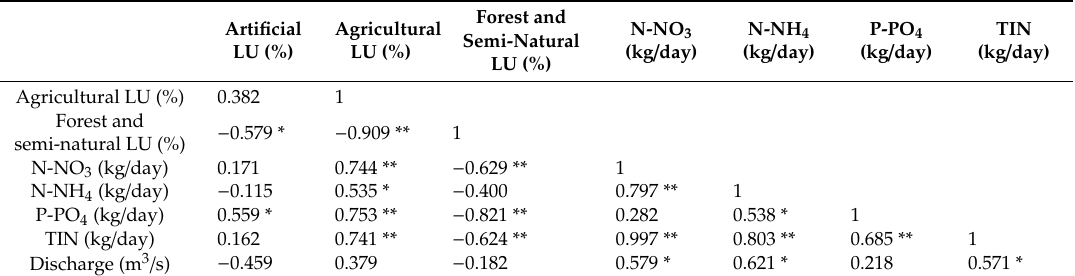
Table 4. Spearman’s rho correlation coe ffi cients between nitrate, ammonium, total inorganic nitrogen, phosphate loads and shares of main land uses (LU) in the catchment. * indicate significant correlations with p ≤ 0.05 and ** with p ≤